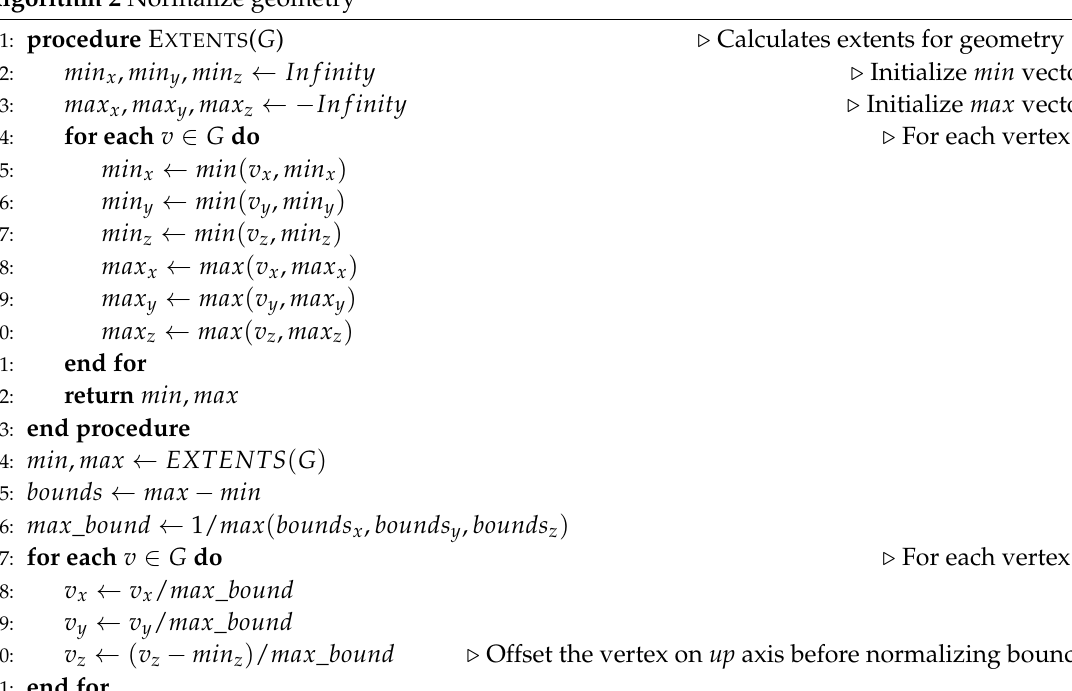
Algorithm 2 Normalize